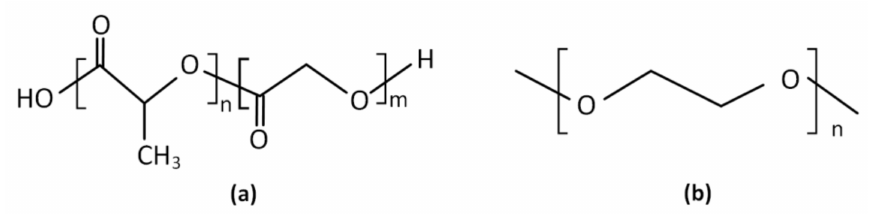
Figure 6. Structures of: ( a ) poly(lactic-co-glycolic acid) (PLGA); ( b ) poly(ethylene glycol)